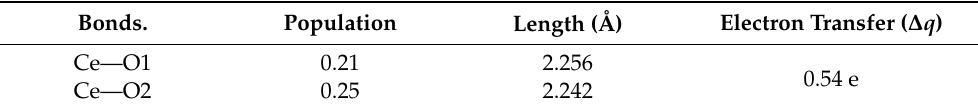
Table 2. Mulliken populations of Ce–O bonds in the chelate